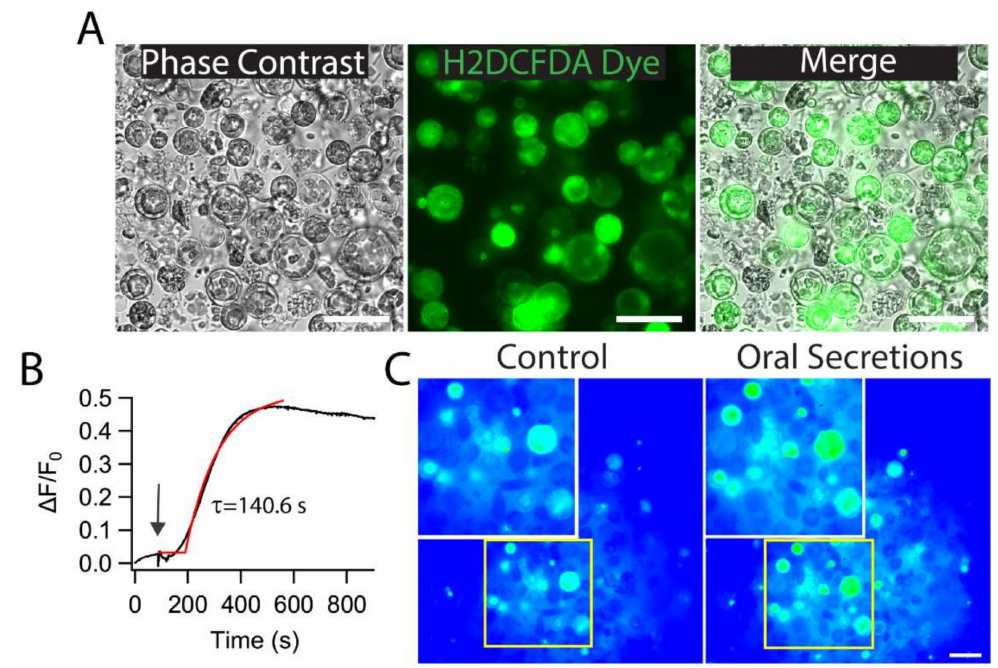
Figure 1. E ff ect of M. sexta oral secretion (OS) on reactive oxygen species (ROS) production in tomato protoplasts. ( A ) Representative phase contrast image (left) of protoplasts at 100 × magnification isolated from tomato leaves. Isolated protoplasts were loaded with ROS-sensing dye CM-H 2 DCFDA (middle). ( B ) Representative ROS imaging trace showing an increase in protoplasts ROS level upon application of M. sexta OS. The data were fitted with a single exponential fit function with a lag of 134.2 ± 11.4 s and a τ of 140.5 ± 5.9 s. ( C ) Representative image of ROS generation in tomato protoplast at 40 × magnification before and after 400 s of M. sexta OS application. Scale bar: 10 µ m. The number of protoplasts ( N ) from 3–5 independent measurements is provided in parentheses in ( B